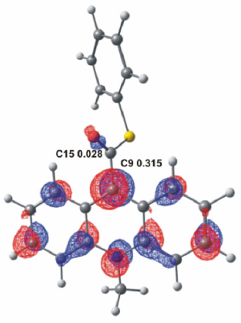
Figure 1. LUMO molecular orbital of acridinium thioester (a) with the values of LCAO coefficient of the p z LUMO orbital at C9 and C15 atoms.